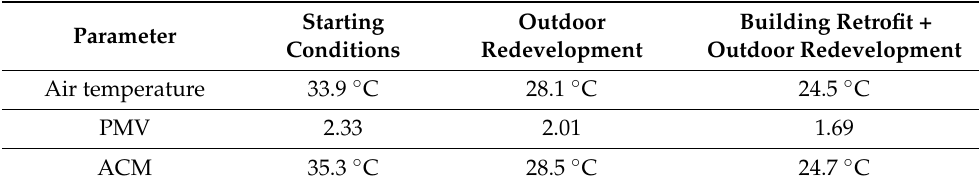
Table 16. Comparison of air temperature, PMV, and ACM output data for the Ponticelli apartment under initial conditions and after the combination of indoor and outdoor strategies.